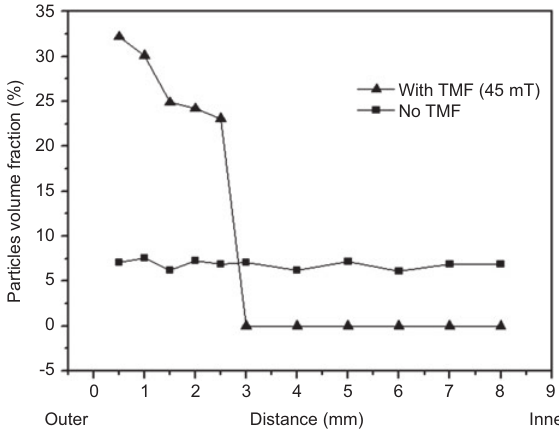
Figure 7 The volume fraction distribution of primary Si particles in the sample.